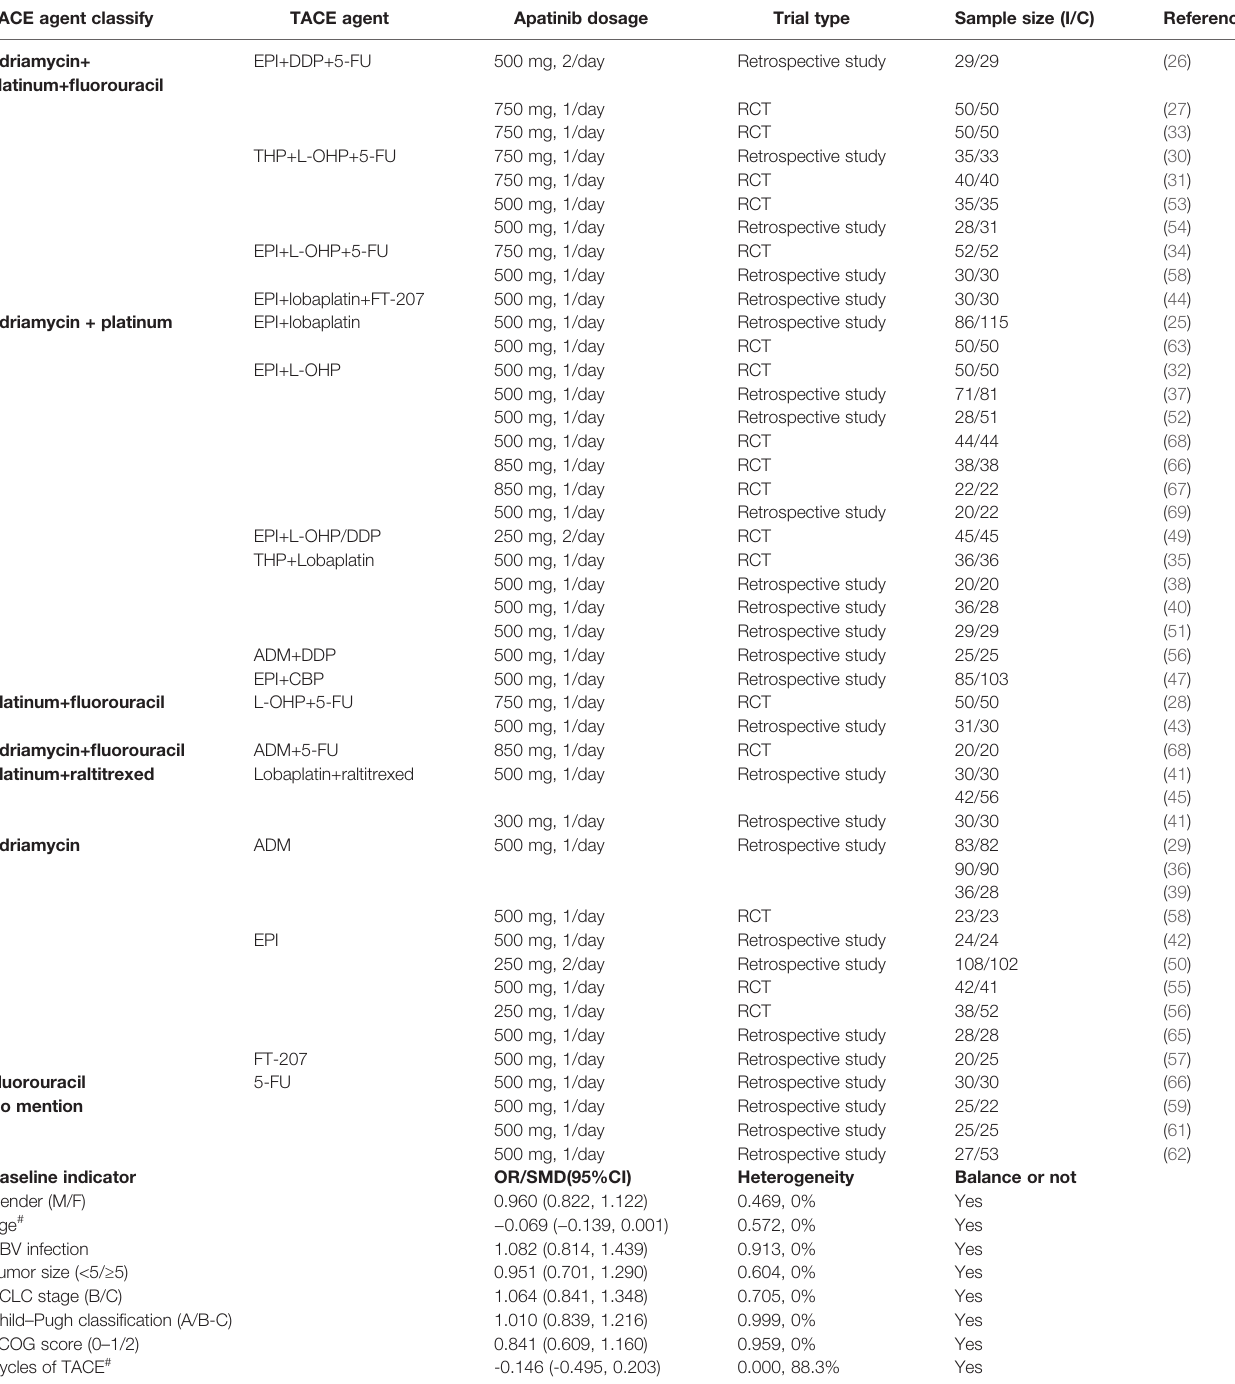
TABLE 1 | Baseline characteristic of included TACE+apatinib versus TACE alone studies. TACE agent classify TACE agent Apatinib